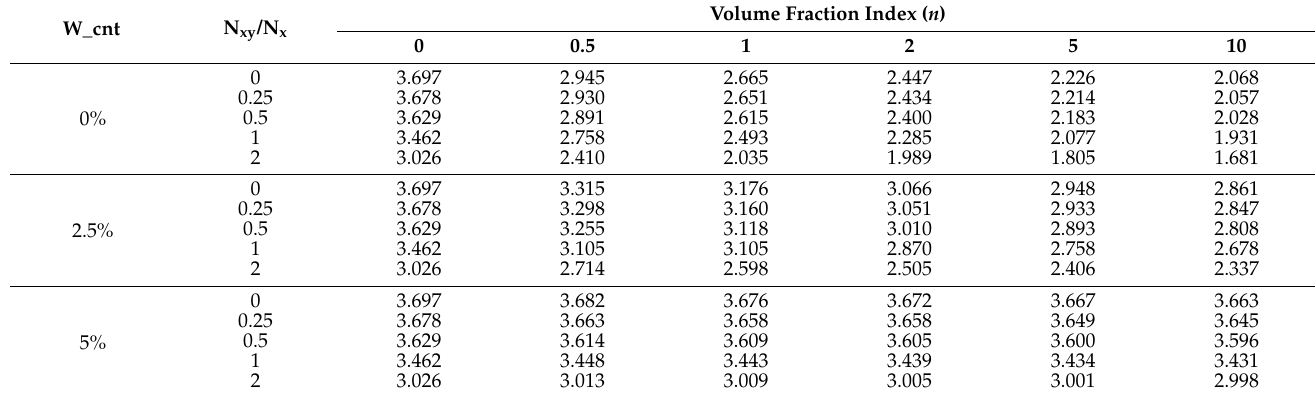
Table 9. Non-dimensional shear buckling load for the simply supported plate.